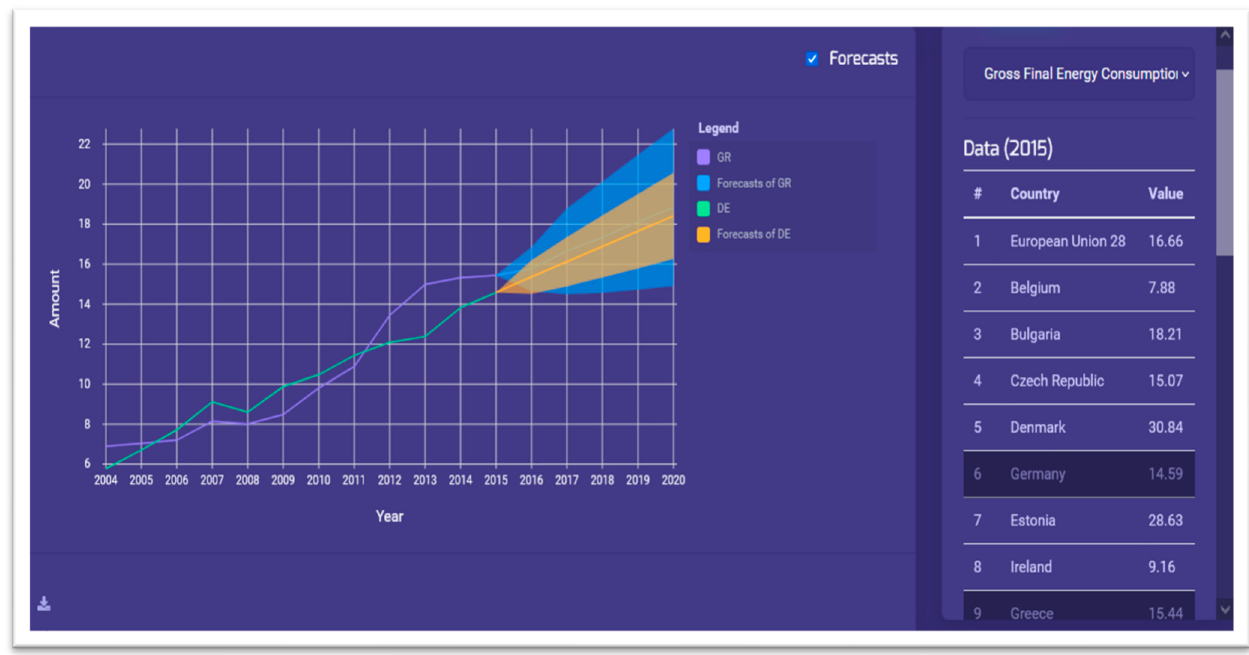
Figure 5. Comparison time series chart of Gross Final Energy Consumption of two EU countries.